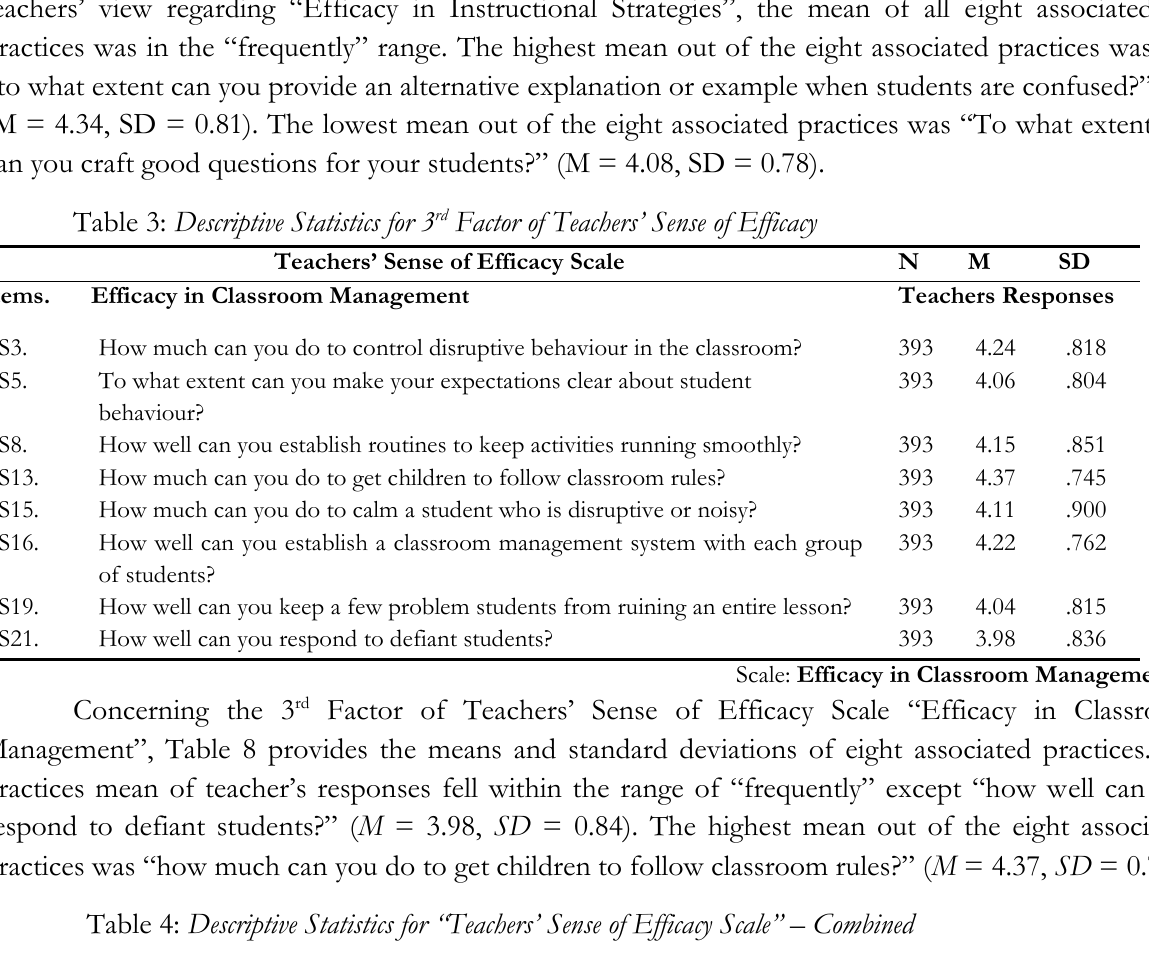
Table 4: Descriptive Statistics for “Teachers’ Sense of Efficacy Scale” – Combined Teachers’ Sense of Efficacy Scale Combined Teacher